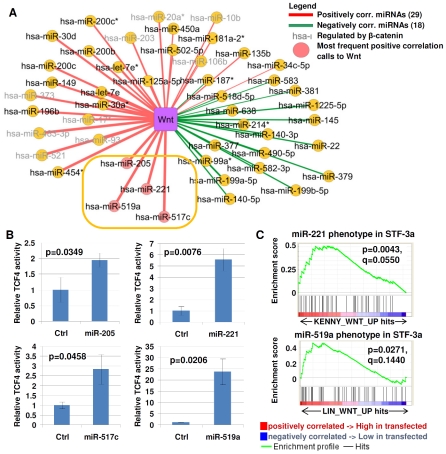
Identifying miRNA–Wnt pathway connections.A) Wnt correlated miRNA. Yellow nodes indicate miRNAs, purple nodes indicate pathways. Color of lines indicate the correlation type (red = positive, green = negative). Thickness of lines indicates frequency of correlation calls across 5 cohorts. miRNAs with the highest frequency of positive correlation calls to the Wnt pathway are marked with pink circles. miRNAs regulated by β-catenin are labeled in grey. The gold oval highlights the miRNAs selected for functional testing. B) TCF/LEF transcriptional acitivity in STF-3a cells transfected with candidate miRNAs. Non-targeting sequences were used as a negative control. (y-axis) TOP-flash reporter activity was measured in RLU (relative light units). C) Geneset enrichment analysis of miRNA-tranfected cells. Top panel, enrichment plot for the Wnt activation signature (KENNY_WNT_UP) in miR-221 overexpressing cells. Bottom panel, enrichment plot for the Wnt activation signature LIN_WNT_UP in miR-519a overexpressing cells. The nominal p-value estimates the statistical significance of the enrichment score for a single geneset. The q-value is the FDR (false discovery rate), adjusted for gene set size and multiple hypotheses testing among MSigDB (C2 collection, Release 2.5).